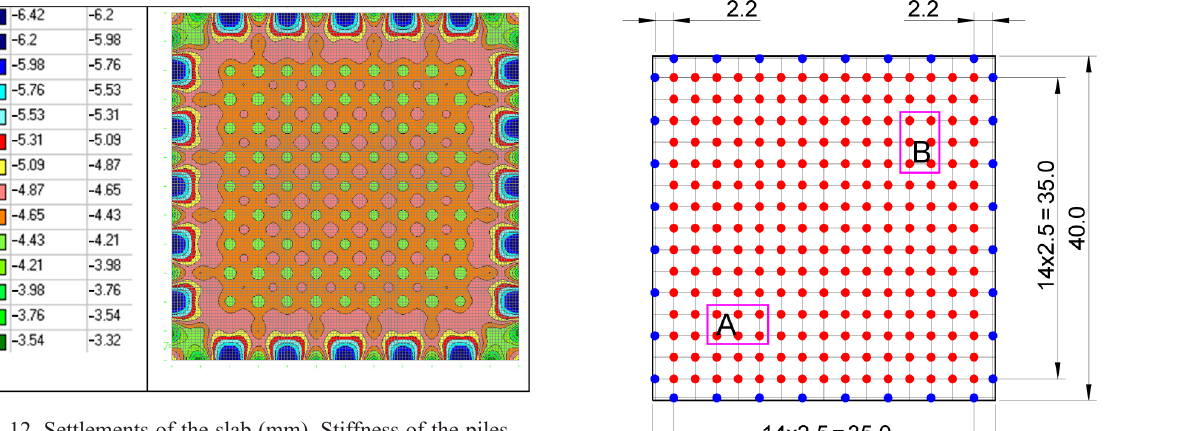
Fig. 12. Settlements of the slab (mm). Stiffness of the piles 80.73 MN/m